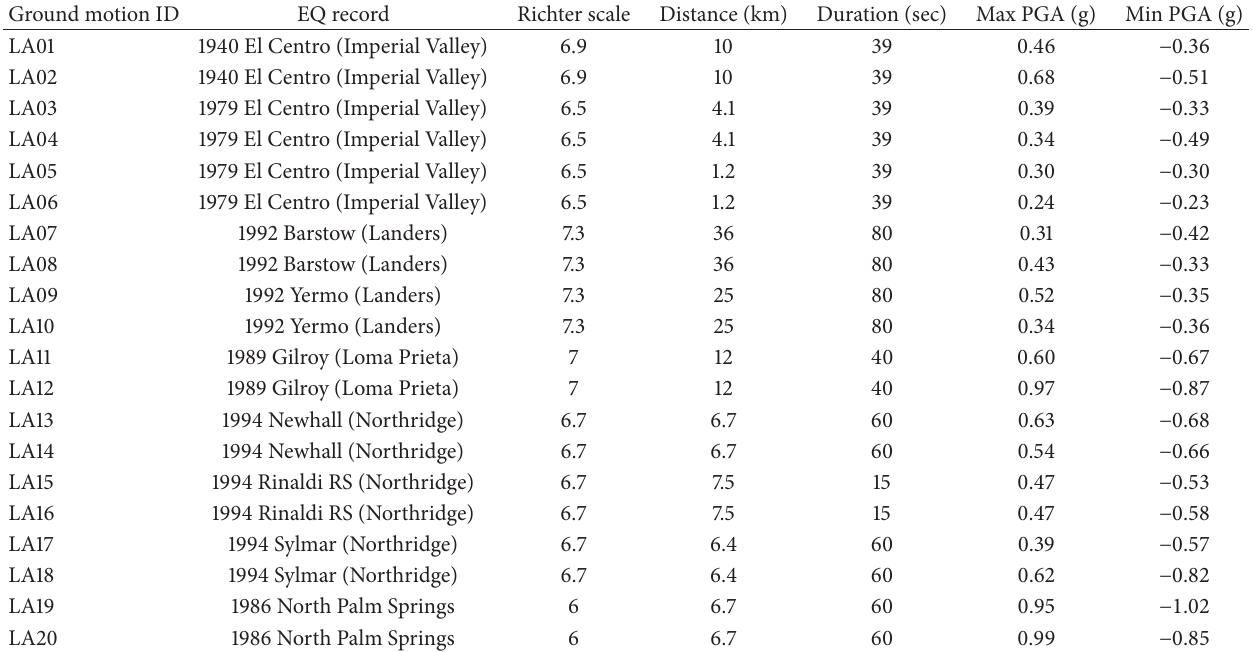
Table 2: Details of Los Angeles ground motions with a probability of exceedance of 10% in 50 years.